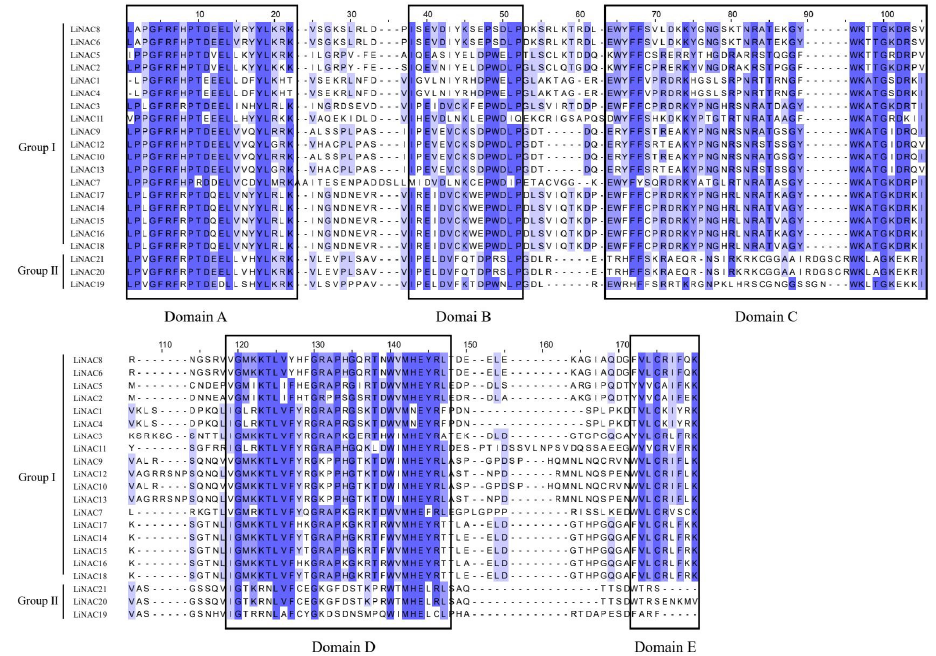
Figure 2. Amino acid sequence alignment of L. indica . The black box lines represent the five subdo- mains ( A - E ) of LiNAC.